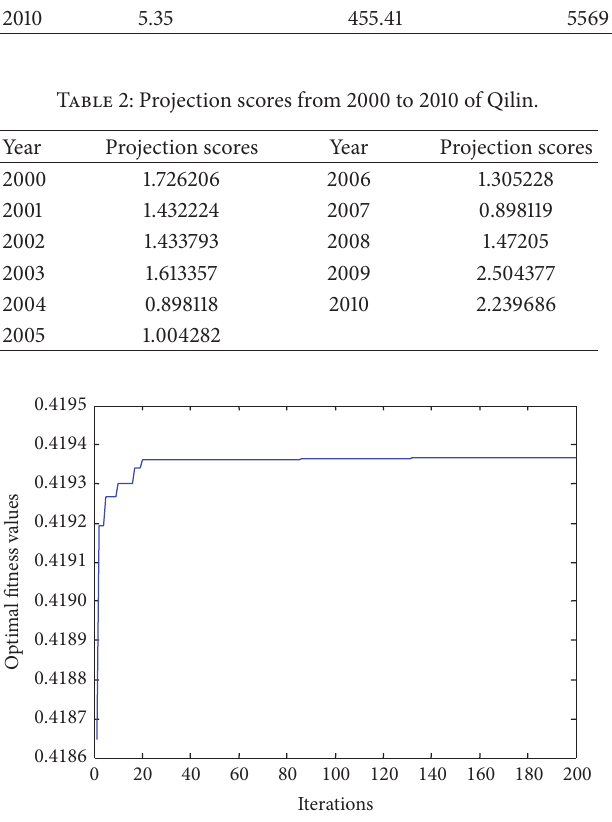
Figure 4: The optimization of projection objective function.